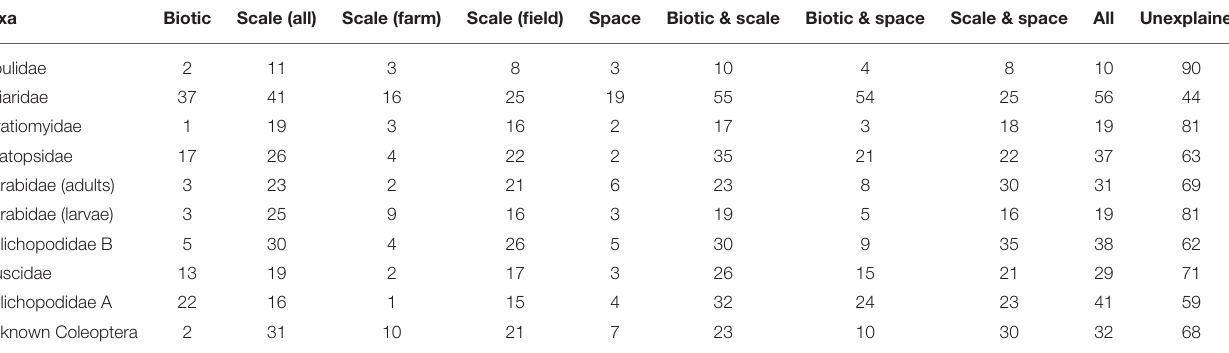
TABLE 3 | The percentage of deviance explained by a GLM with binomial distribution through partitioning the dependent variable (species presence/absence, for taxa with ≥ 5 individuals) between three groups of explanatory variables (biotic, scale, and space), alone and in combination, and the deviance unexplained by the variables in this study for each taxa in 2012.